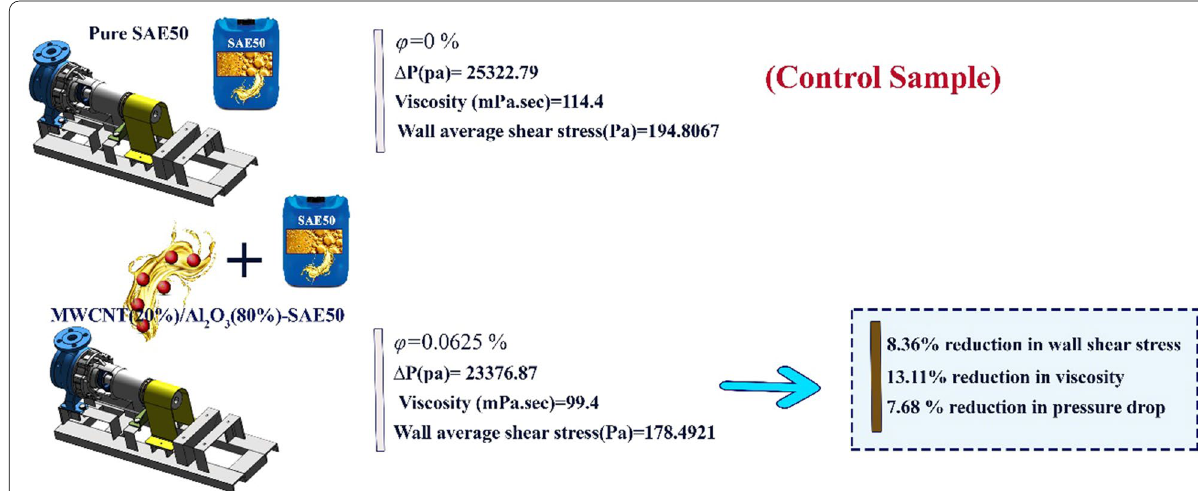
Fig. 2 The performance of nano-lubricants at different conditions